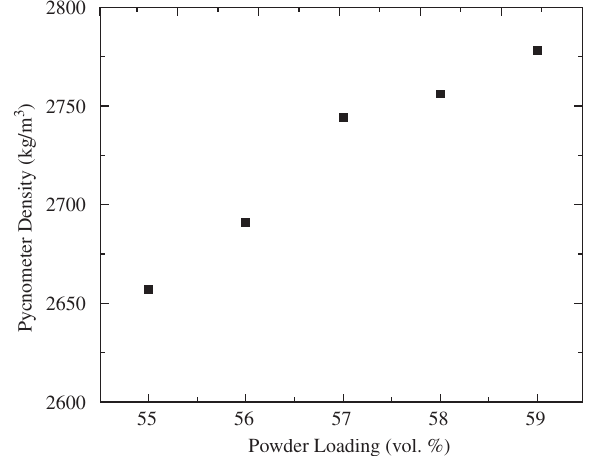
Figure 1. Scanning electron micrograph of alumina.